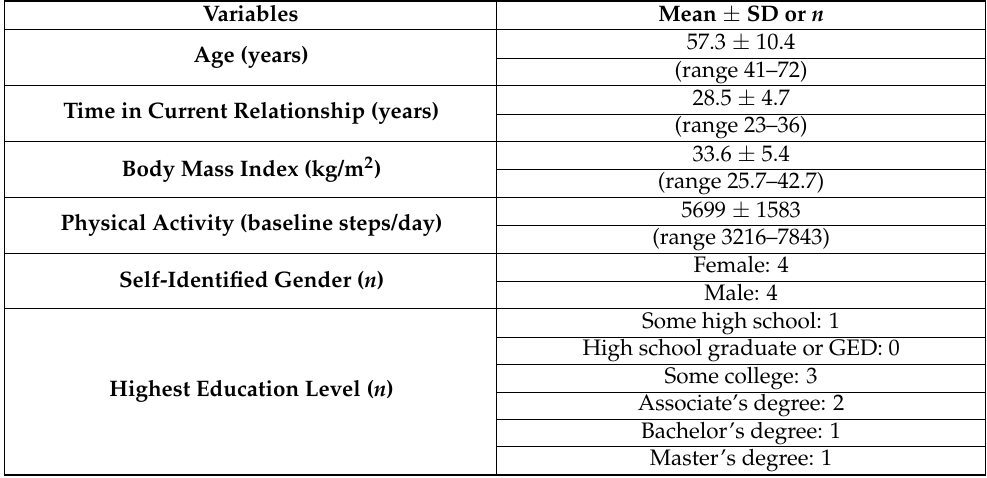
Table 2. Descriptive characteristics of participants at intervention baseline ( N =